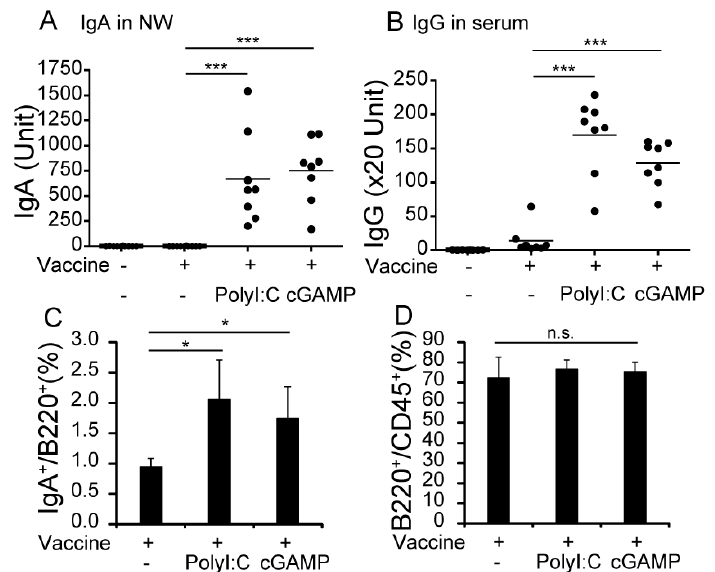
Figure 1. 2 ′ 3 ′ cyclic guanosine monophosphate–adenosine monophosphate (cGAMP) enhances vaccine-specific Ig production in mice. Wild-type (WT) mice were intranasal (i.n.) vaccinated with 1 µ g of hemagglutinin (HA) split vaccine with or without 2 µ g of cGAMP or 3 µ g of polyinosinic-polycytidylic acid (polyI:C) twice. Two weeks after the second vaccination, nasal wash (NW) and serum were collected to measure vaccine-specific immunoglobulin (Ig) A ( A ) and IgG ( B ) antibody (Ab) production by enzyme-linked immunosorbent assay (ELISA). The horizontal bars show the average of 8–10 mice for groups pooled from two independent experiments. Nasal-associated lymphoid tissue (NALT) cells were isolated from vaccinated mice and stained with fluorescein isothiocyanate (FITC)-labeled anti-IgA, phycoerythrin (PE)-labeled anti-B220, and allophycocyanin (APC)-labeled anti-CD45 Abs, and subjected to flow cytometric analysis. The proportions and numbers of IgA + B cells and B220 + B cells in NALT were analyzed by flow cytometry. ( C , D ) The proportions of IgA + in B220 + B cells and B220 + cells in CD45 + cells in NALT after vaccination. The bars show average of the 4–5 mice for each group. * p < 0.05; *** p < 0.001, n.s.: not significant in the Mann-Whitney U test. One representative experiment out of three is shown.